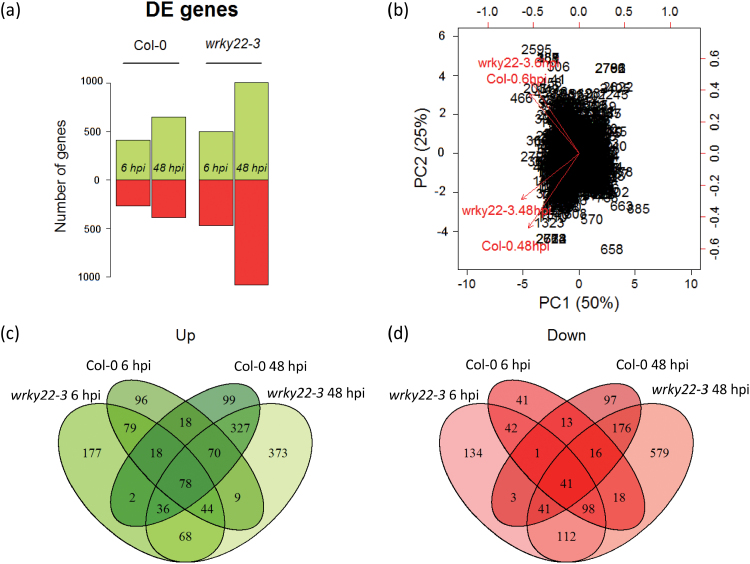
Differentially expressed (DE) genes between treatments with and without aphids in the wild-type and wrky22-3. (A) The number of DE genes between control and infestation treatments (green bars: up-regulated, red bars: down-regulated). (B) Biplot of the two first principal components of differentially expressed genes between control and infestation treatments (DE genes ≥2-fold). (C) Overlap in up-regulated genes, and (D) down-regulated genes.